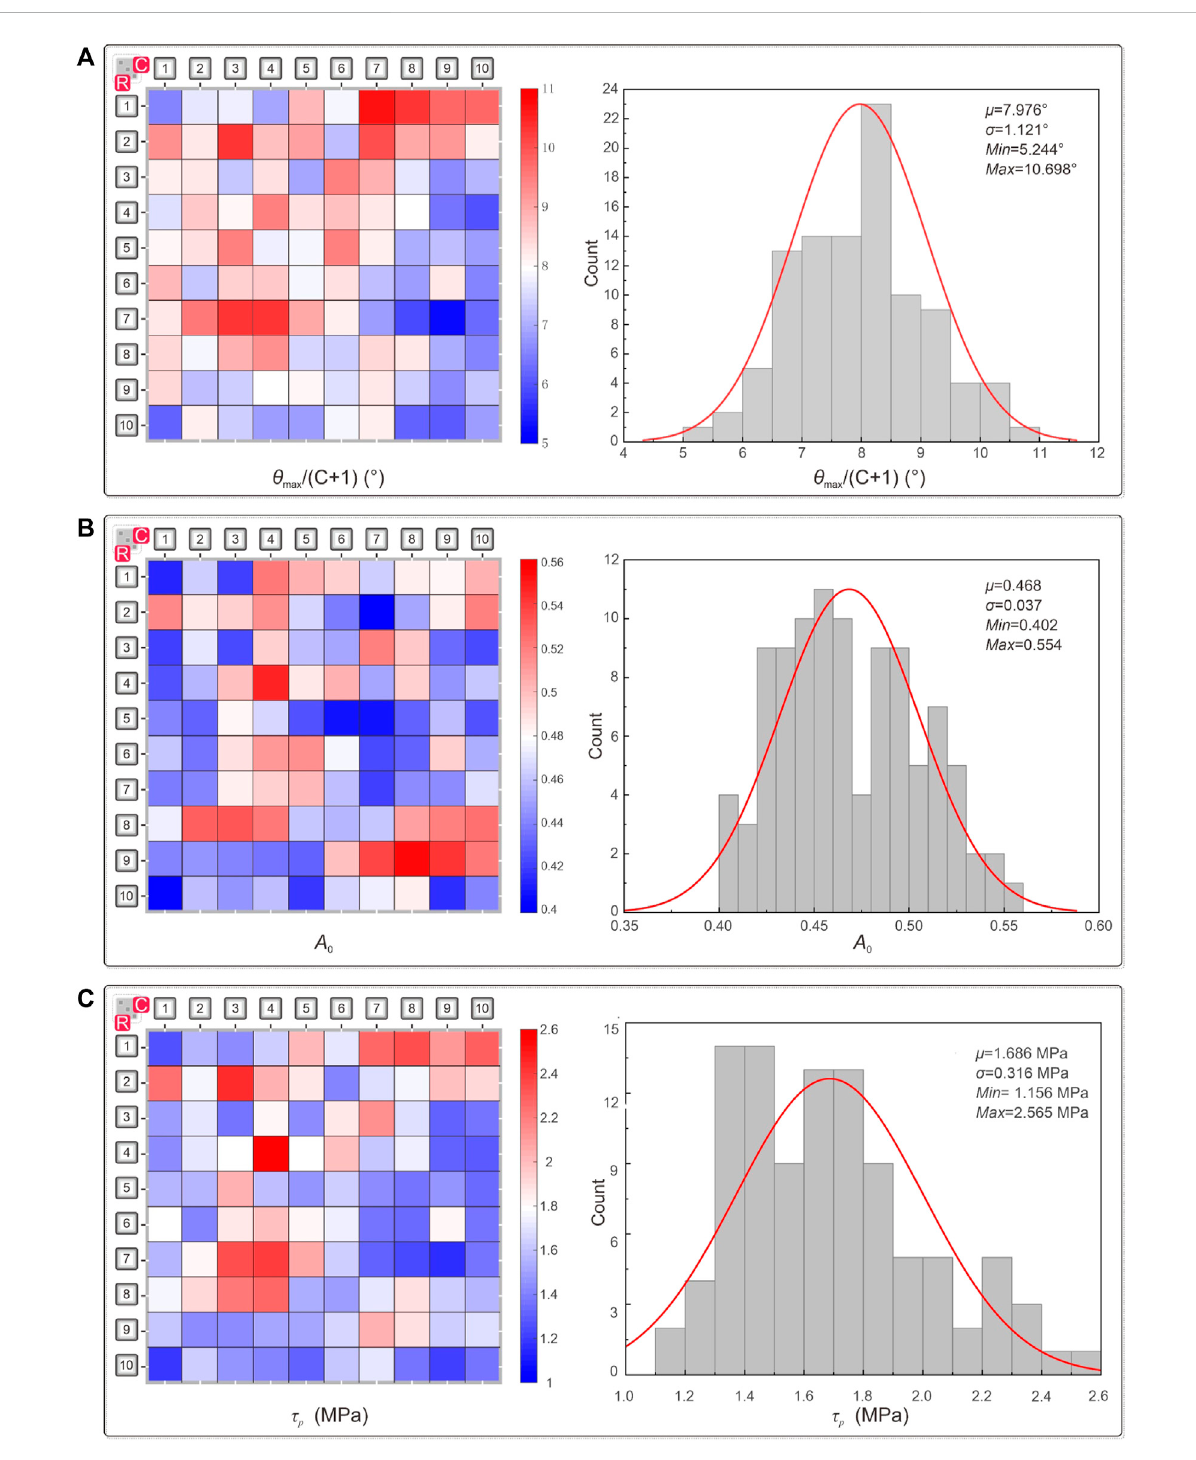
FIGURE 3 The heterogeneity of roughness and shear strength of the specimens. (A) θ p max / [ C + 1 ] 3 D ; (B) A 0 ; (C) shear strength τ p ( σ n = 1.0